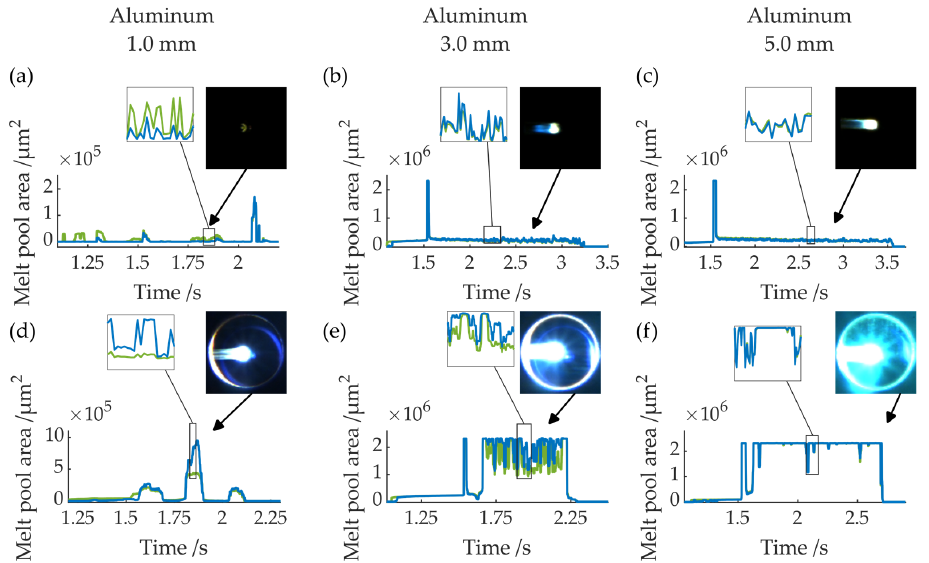
Figure 5. Signals for the green and blue channels of complete cuts ( a – c ) and incomplete cuts ( d – f ) and an example image of the corresponding signal highlighted by black arrows for aluminum for sheet thicknesses of 1.0, 3.0, and 5.0 mm.